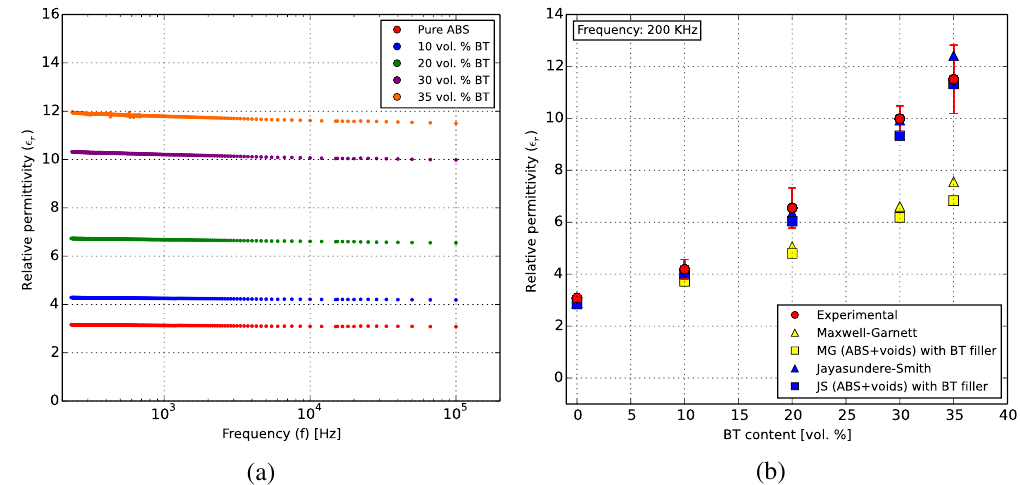
Figure 13. ( a ) The dielectric behavior of pure ABS and the ABS-BT composites over a frequency sweep from around 250 Hz–200 kHz. ( b ) A correlation of the obtained results (red circles) with the Maxwell-Garnett (yellow) and Jayasundere-Smith (blue) effective medium approximations at 200 kHz, with and without the effect of voids as a part of the matrix material in the samples (triangles and squares,